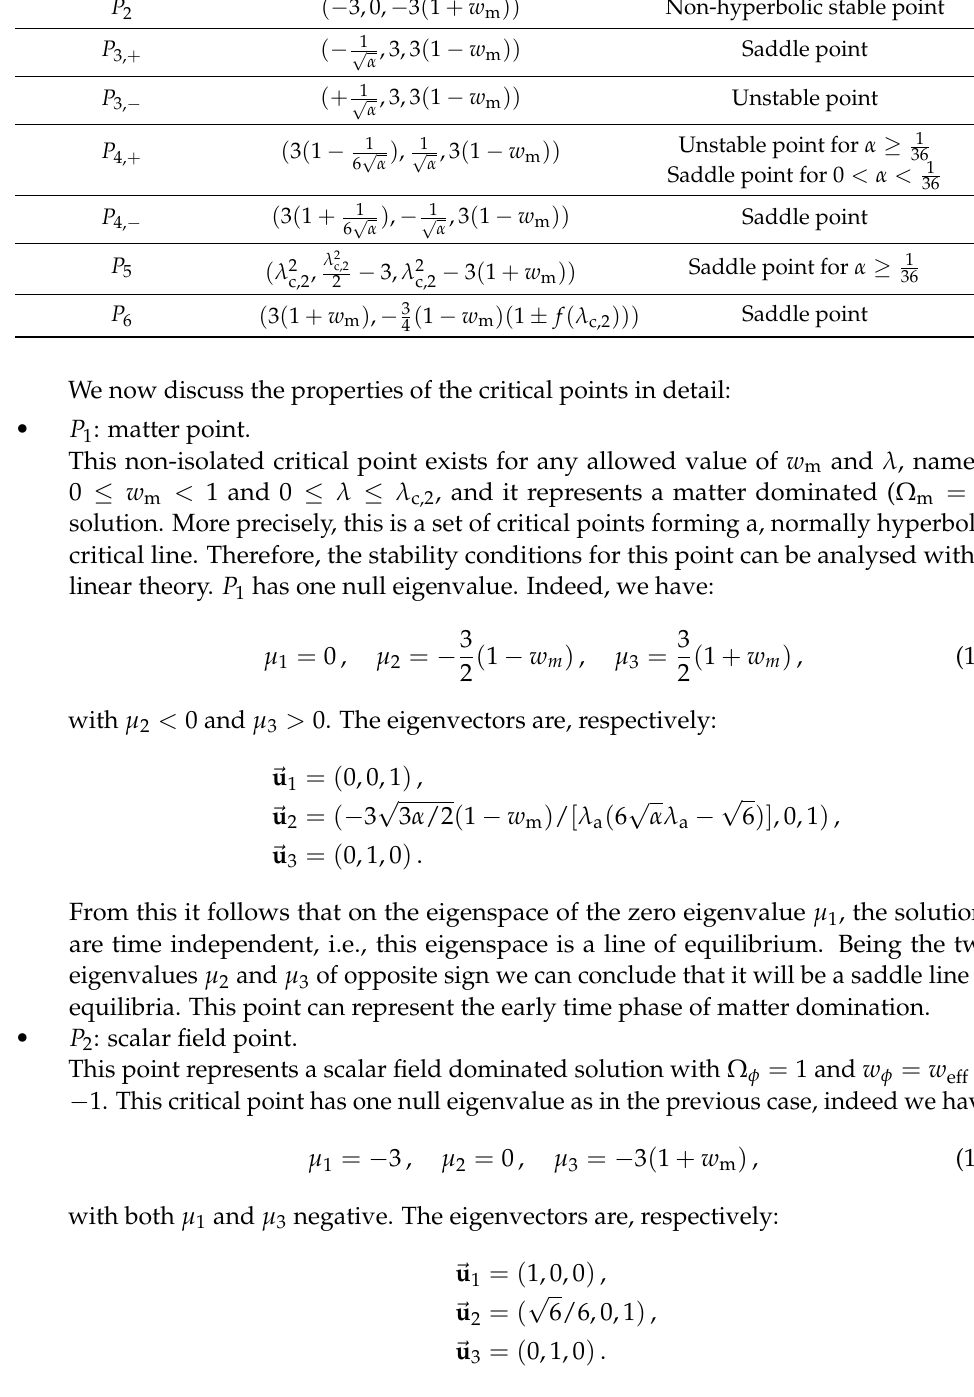
Table 2. Stability analysis for the dynamical system with the Recliner model. We show the values of the eigenvalues µ i , with i ∈ ( 1,2,3 ) and the condition(s) for stability. Point ( µ 1 , µ 2 , µ 3 ) Stability ( 1 − w m ) , 3 ( 1 + w m )) Saddle P 1 ( 0, − 3 2 2